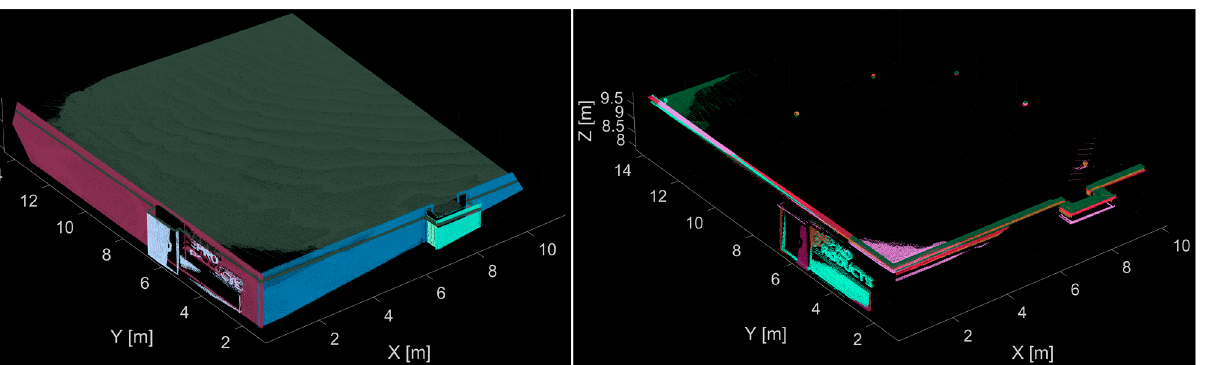
Table 3. Characteristics of plane segmentation.